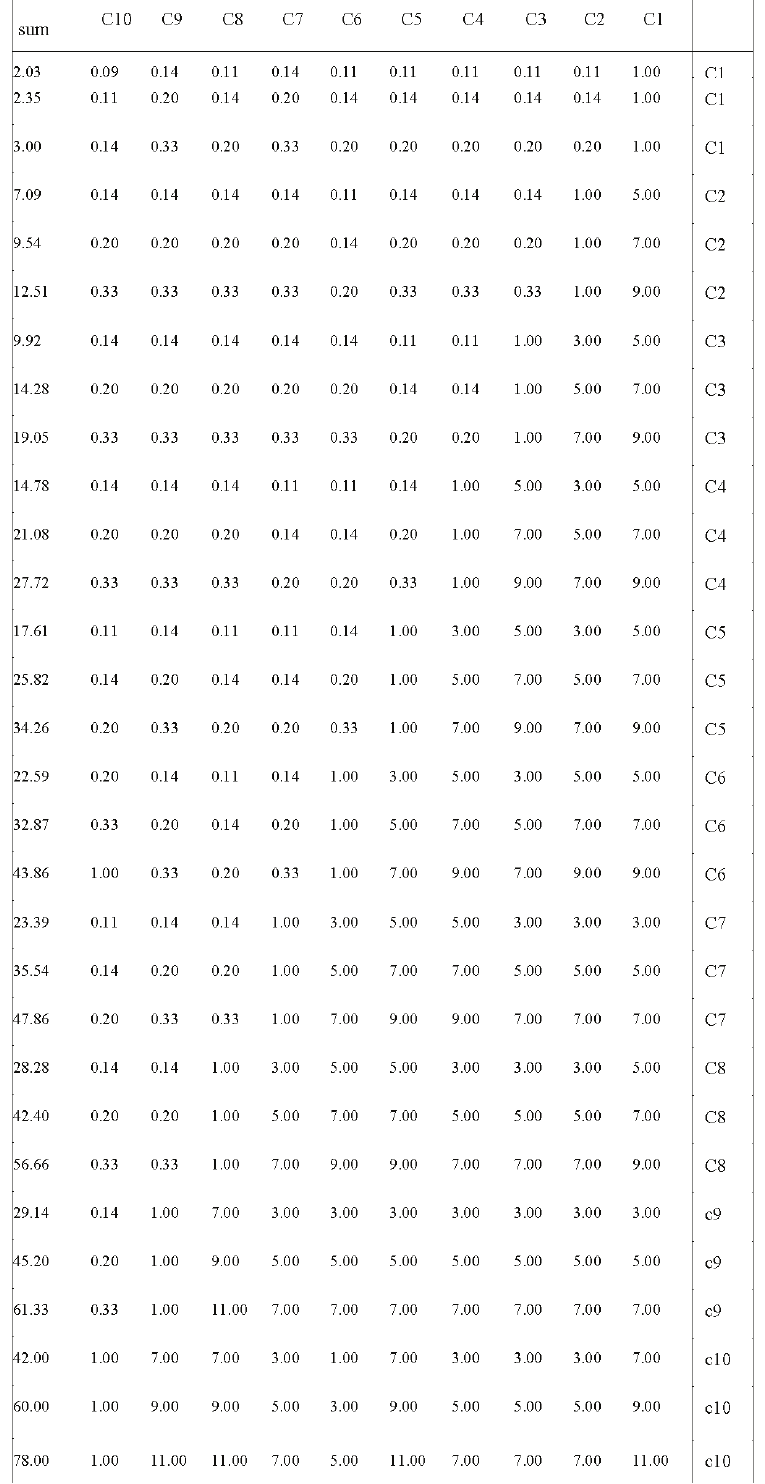
Table 4. Degree of possibility of each